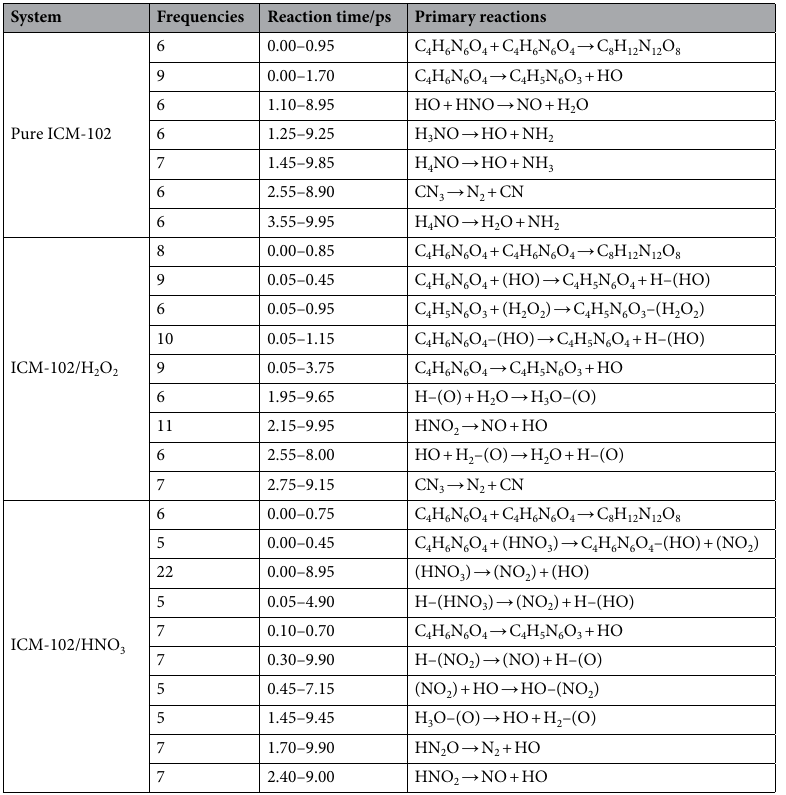
Table 2. Primary reactions of the pure ICM-102, ICM-102/H 2 O 2 , and ICM-102/HNO 3 systems at 3000